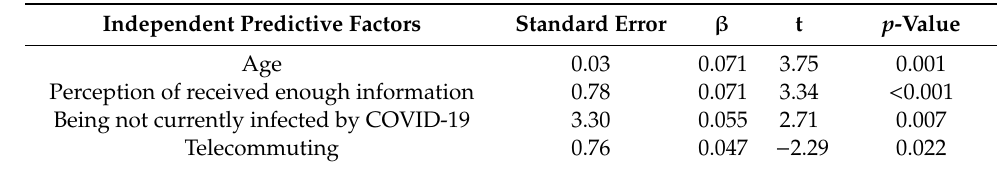
Table 4. Multiple linear regression analysis of independent predictive factors related to COVID-19 infection for a higher occupational